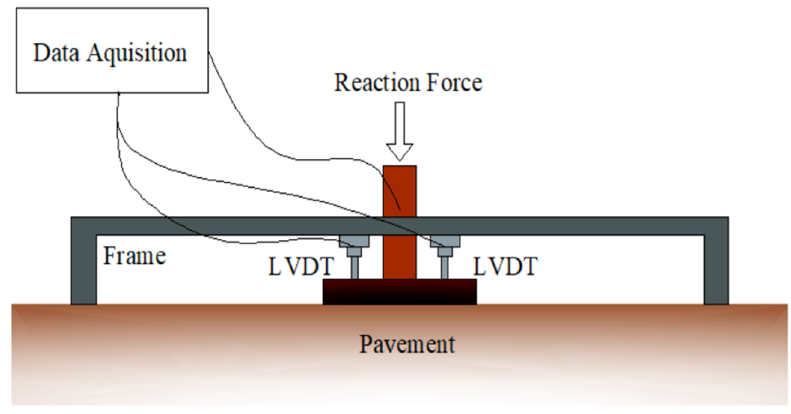
Figure 6. Schematic for PLT setup.